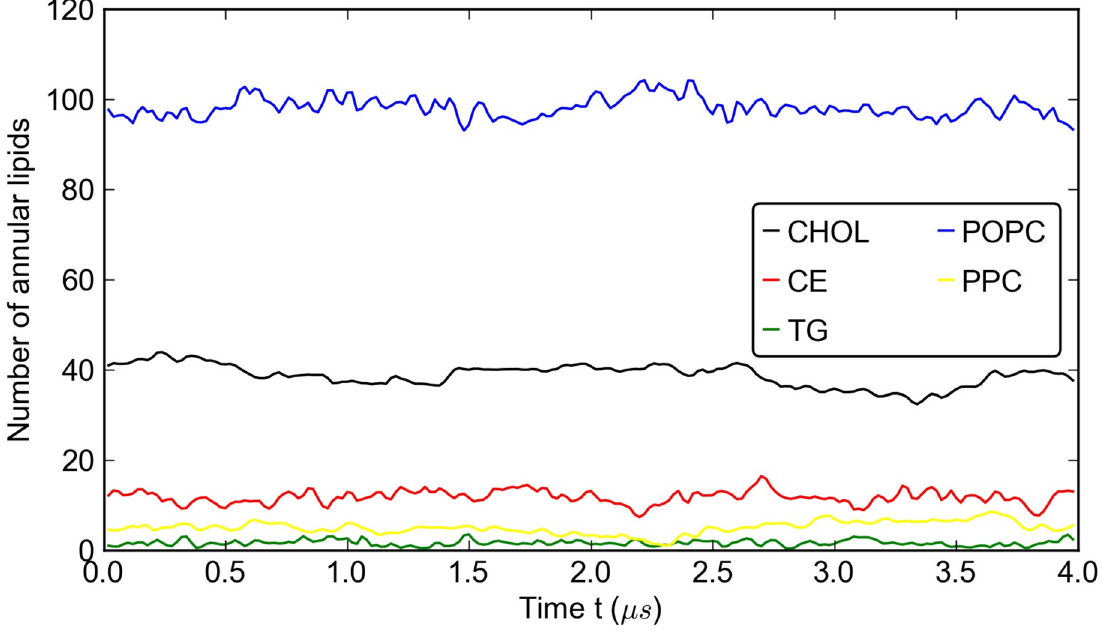
Figure 8. Number of annular lipid molecules over the last 4 m s of the simulation of the full HDL particle: POPC (blue), CHOL (red), CE (orange), PPC (purple) and TG